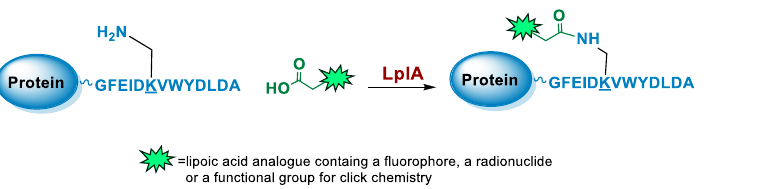
Figure 5. Protein derivatization with lipoic acid ligase. LplA derivatizes a protein fused to the 13 amino acid sequence of the LAP tag with a lipoic acid analogue. The enzyme catalyzes the formation of an amide bond between the ε-primary ammine of a Lys residue in the LAP tag and the carbox- ylate group of an alkyl carboxylate containing a functional handle.